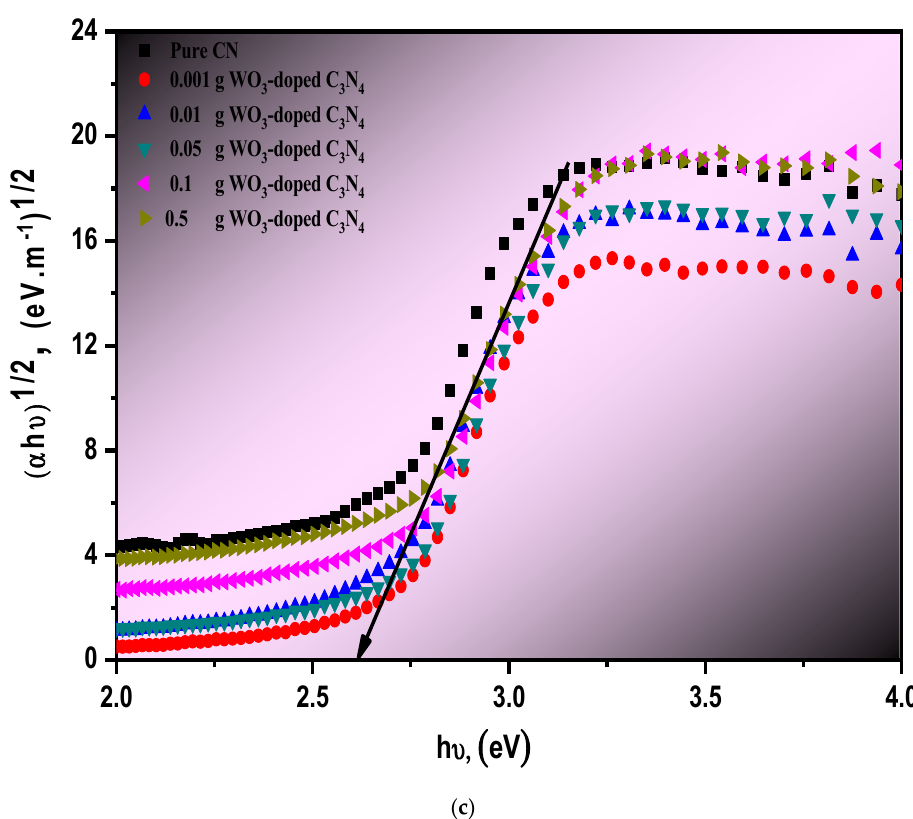
Figure 3. ( a - c ) Diffused reflectance optics UV-Vis ( a ), ( α h υ ) 2 ( b ) and ( α h υ ) 1/2 ( c ) versus the incident photon energy h υ of pure g-C 3 N 4 and its WO 3 /g-C 3 N 4, with various amounts of tungsten oxide (0.001, 0.01, 0.05, 0.1, and 0.5 g of WO 3 ).